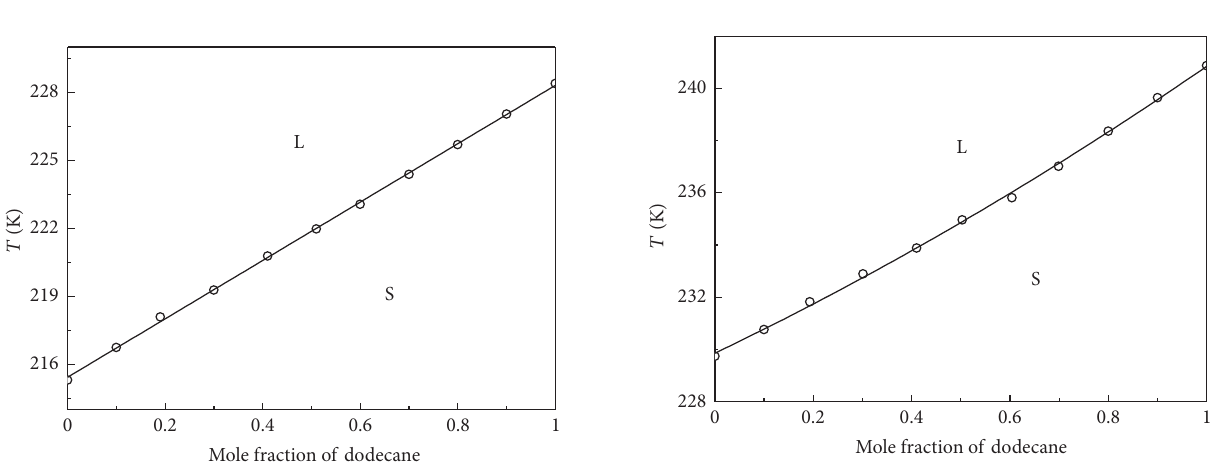
-C system con�ned 11 12